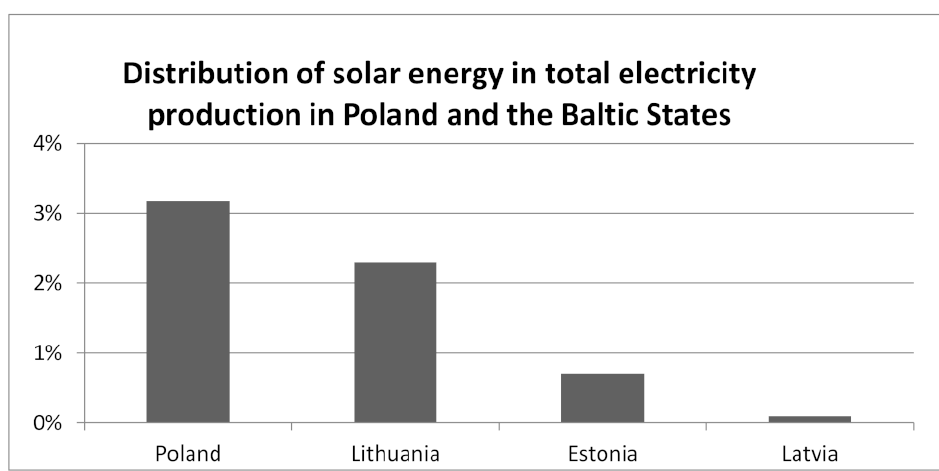
Figure 5. Distribution of the share of solar energy in the total volume of electricity production in Poland and the Baltic States